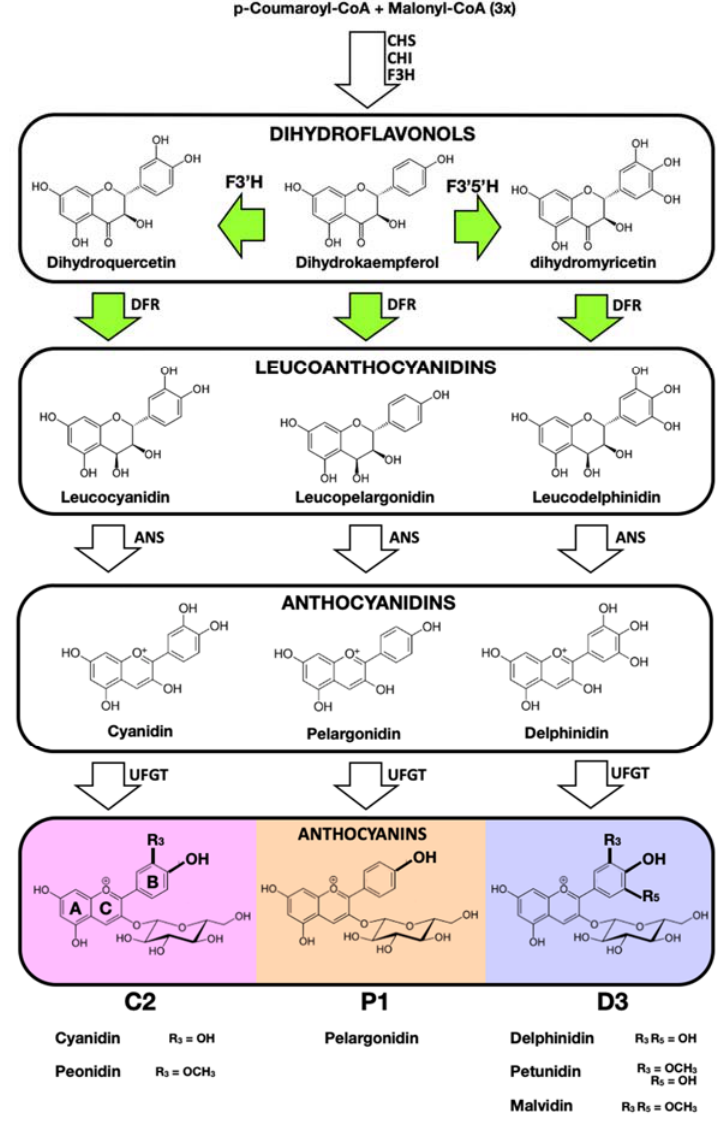
Figure 1. Schematic representation of the late stages of the anthocyanin biosynthetic pathway leading to the production of three classes of anthocyanins (here abbreviated as P1, C2 and D3) with different colour properties associated with the pattern of hydroxylation of the B-ring. Key genes required for the differential accumulation of P1, C2 or D3 are indicated by green arrows.